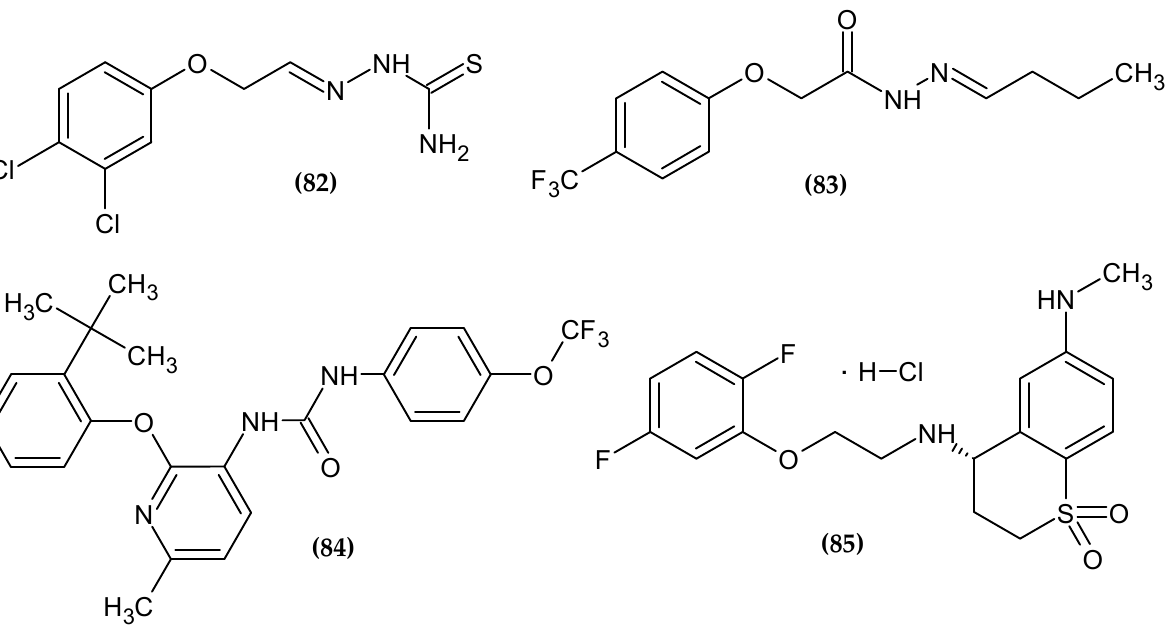
Figure 26. The novel potential agents with other activity bearing a phenoxy group.